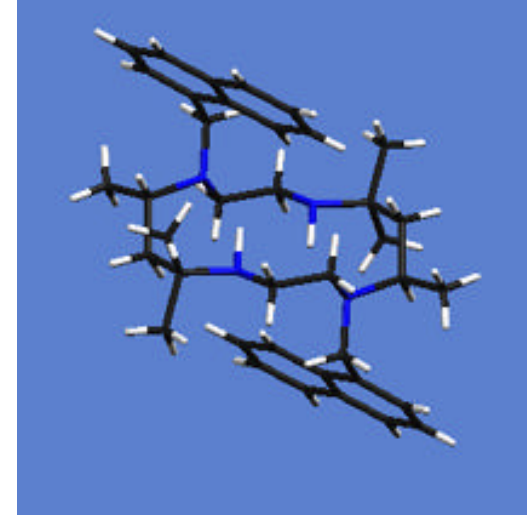
Figure 2. Mercury 1.1 display of meso-5,5,7,12,12,14-hexamethyl-1,4,8,11-